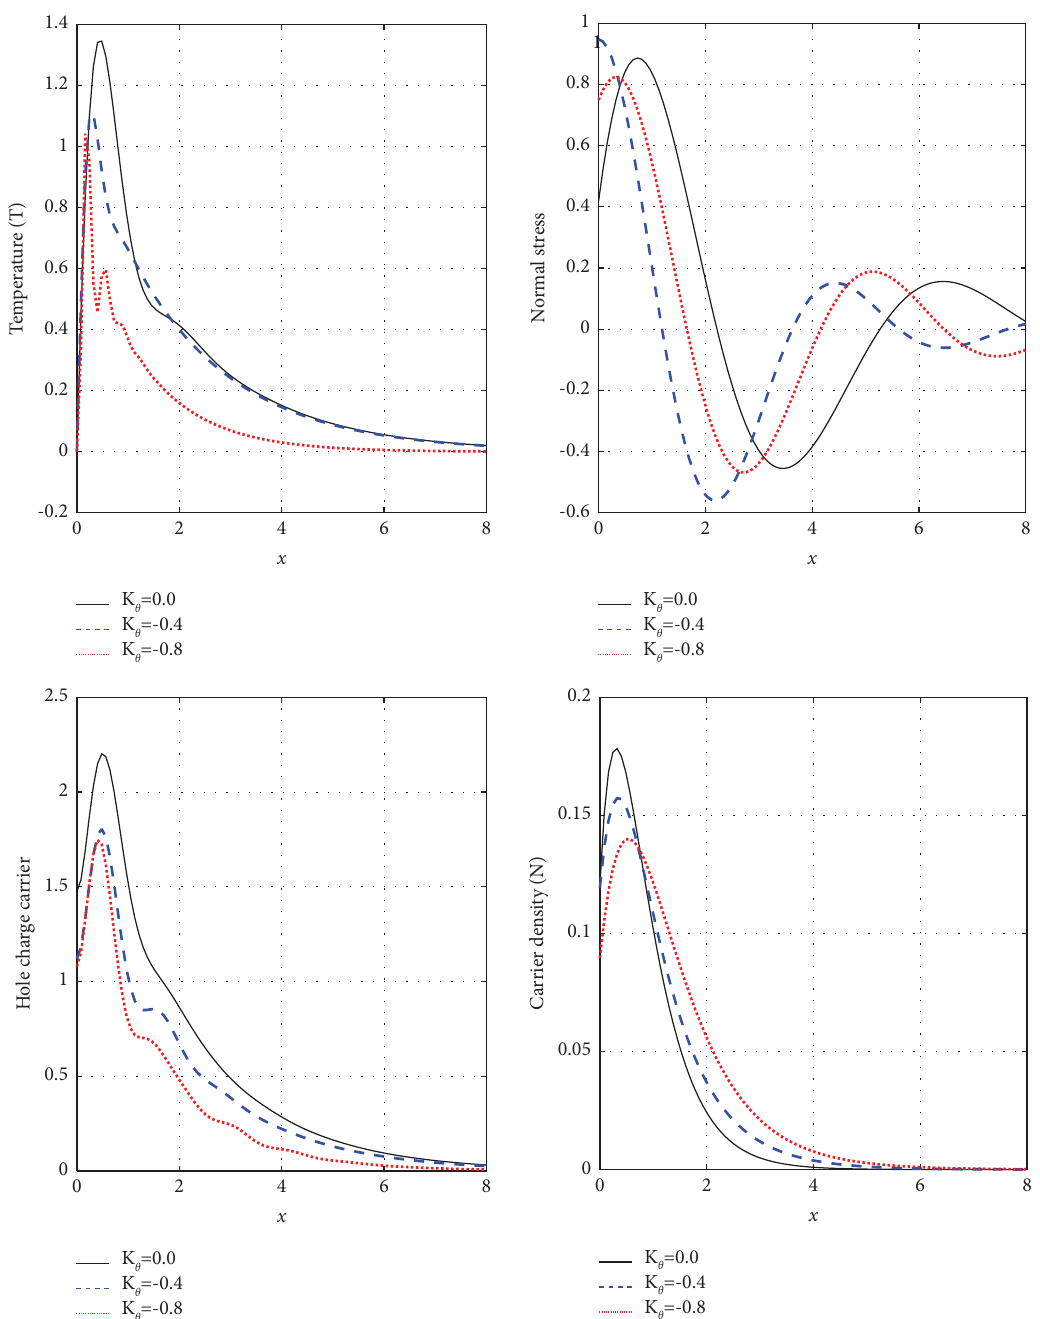
Figure 3: Te variation of the physical feld distributions verses the axial distance in three cases of thermal conductivity under the impact of Hall current according to the DPL